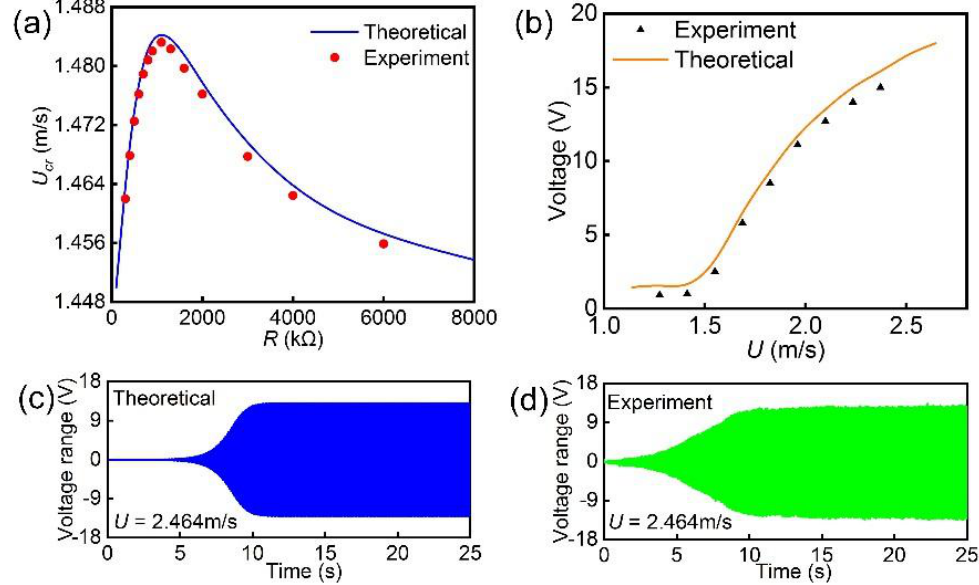
Figure 3. Verification of the theoretical model: ( a ) the critical wind speed U cr versus R ; ( b ) the output voltage versus R ; ( c ) and ( d ) are respectively theoretical and experimental time-domain output voltage range of the GEH-PTC at U = 2.464 m/s and R = 1.1 MΩ.